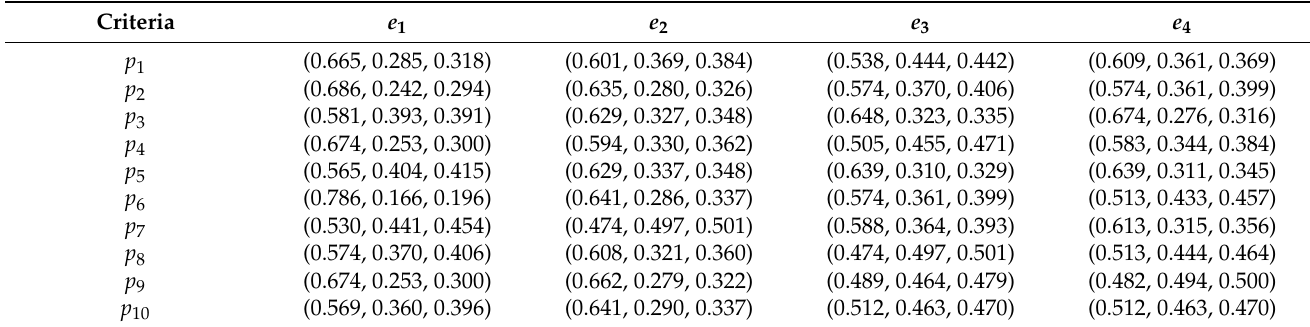
Table 8. Normalized A-SVN-DM for RESs selection.